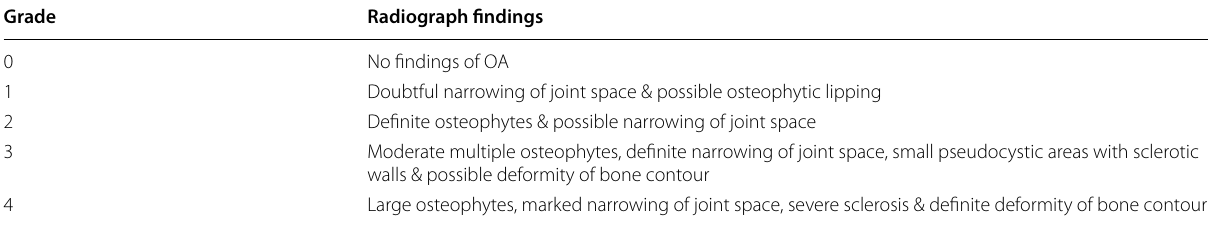
Table 1 KL classification system for knee OA